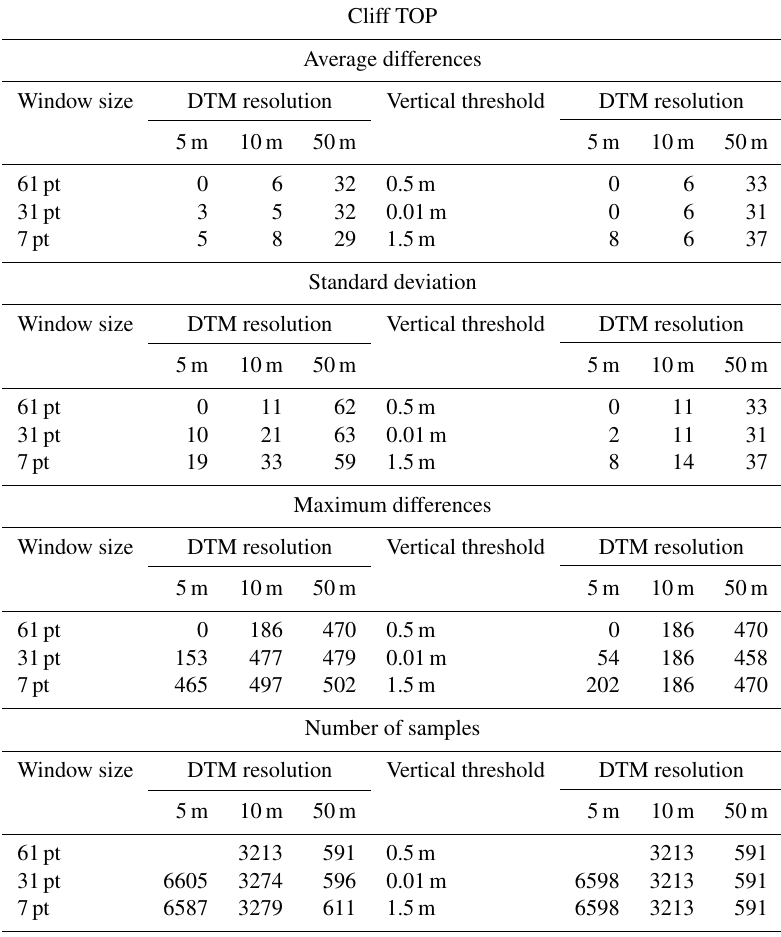
Table 5. Cliff top average, standard deviation, maximum difference and number of samples for the sensitivity analysis to DEM resolution, window size for coastline smoothing and vertical threshold. Cliff